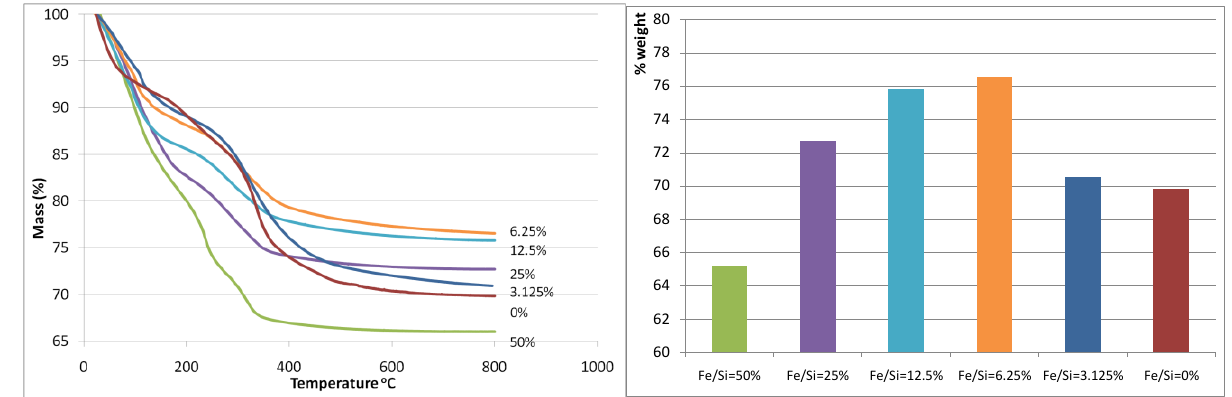
Figure 2. Differential of the TGA for samples prepared with varying Fe/Si molar ratios.